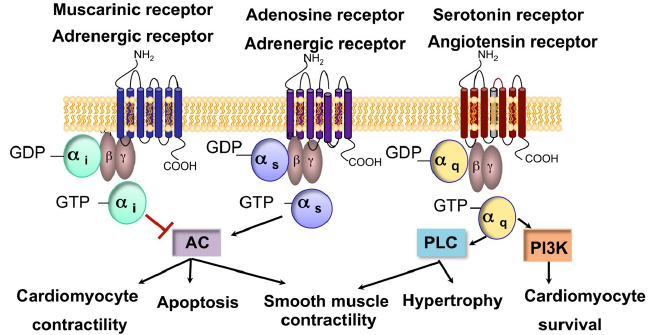
Figure 1. Many hormones and neurotransmitters use G protein-coupled receptors (GPCRs) to maintain cardiovascular homeostasis. G  s signaling via adenylyl cyclase (AC) regulates heart rate and contractility in response to catecholamine stimulation, but excessive G  s signaling in the heart eventually induces myocardial hypertrophy, fibrosis and necrosis. G  q signaling promotes cardiac hypertrophy or protects cardiomyocytes